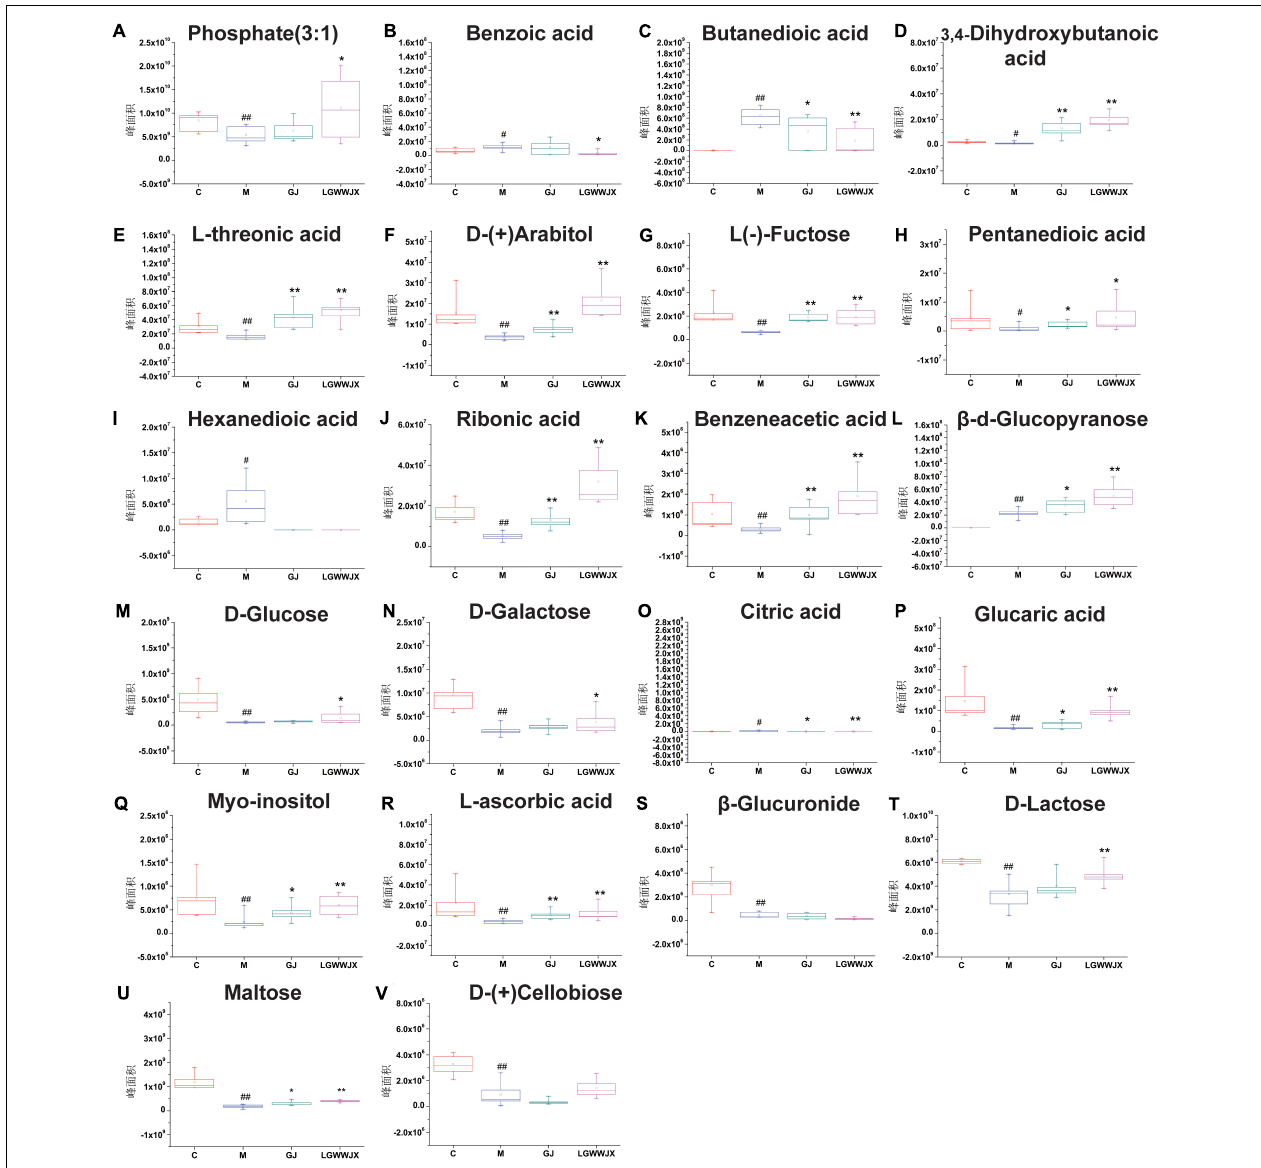
FIGURE 6 | Levels differentially expressed metabolites in urine. (A) Phosphate(3:1); (B) Benzoic acid; (C) Butanedioic acid; (D) 3, 4-Dihydroxybutanoicacid; (E) L -threonic; (F) D -(+)arabitol; (G) L -(–)Fructose; (H) Pentanedioic acid; (I) Hexanedioic acid; (J) Ribonic acid; (K) Benzeneacetic acid; (L) β - D -Glucopyranose; (M) D -Glucose; (N) D -Galactose; (O) Citric acid; (P) Glucaric acid; (Q) Myoinositol; (R) L -Ascorbic acid; (S) β -Glucuronide; (T) D -Lactose; (U) Maltose; (V) D -(+)Cellobiose. C, control group; M, model group; GJ, Gan Jiang decoction group; LGWWJX, LGWWJX decoction group. # p < 0.05, ## p < 0.01, compared with the control group. ∗ p < 0.05, ∗∗ p < 0.01, compared with the model